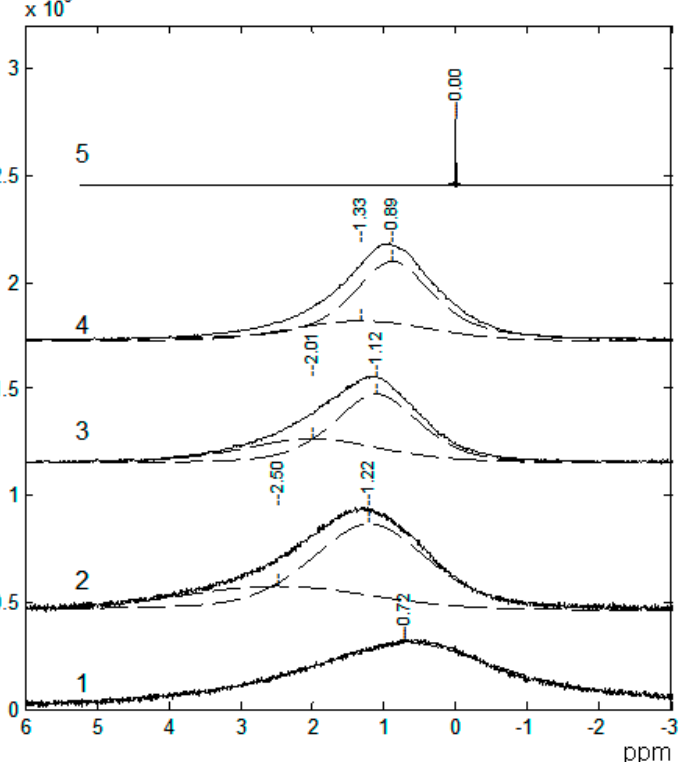
Figure 8. 7 Li NMR spectra: 1, sample no. 1; 2, sample no. 2; 3, sample no. 5; 4, sample no. 9; 5, 1 M LiClO 4 solution in ethylene carbonate [53].